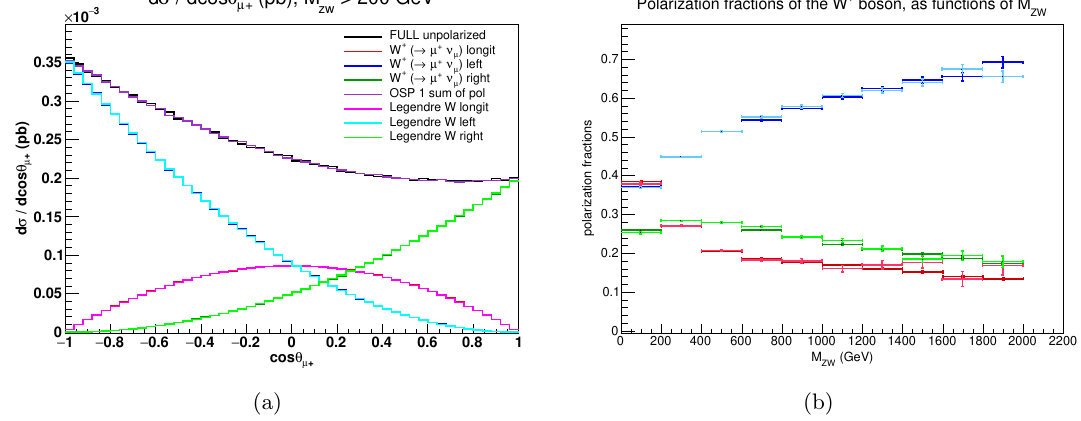
Figure 5 . W + Z scattering: cos (cid:18) distributions for a polarized W + , in the region M WZ > 200 GeV (cid:22) + (left), and polarization fractions as functions of M WZ (right). Comparison between Monte Carlo distributions and results extracted from the full cos (cid:18) distribution by projecting into the (cid:12)rst (cid:22) + three Legendre polynomials. No lepton cuts, no neutrino